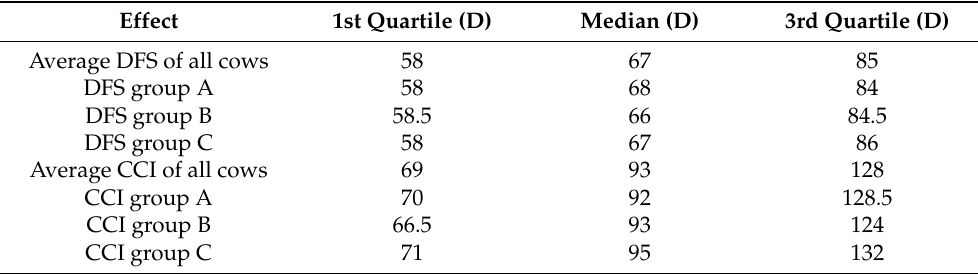
Table 2. Median, 1st, and 3rd quartile (in days) of DFS and CCI, according to all cows, group A, B, and C.